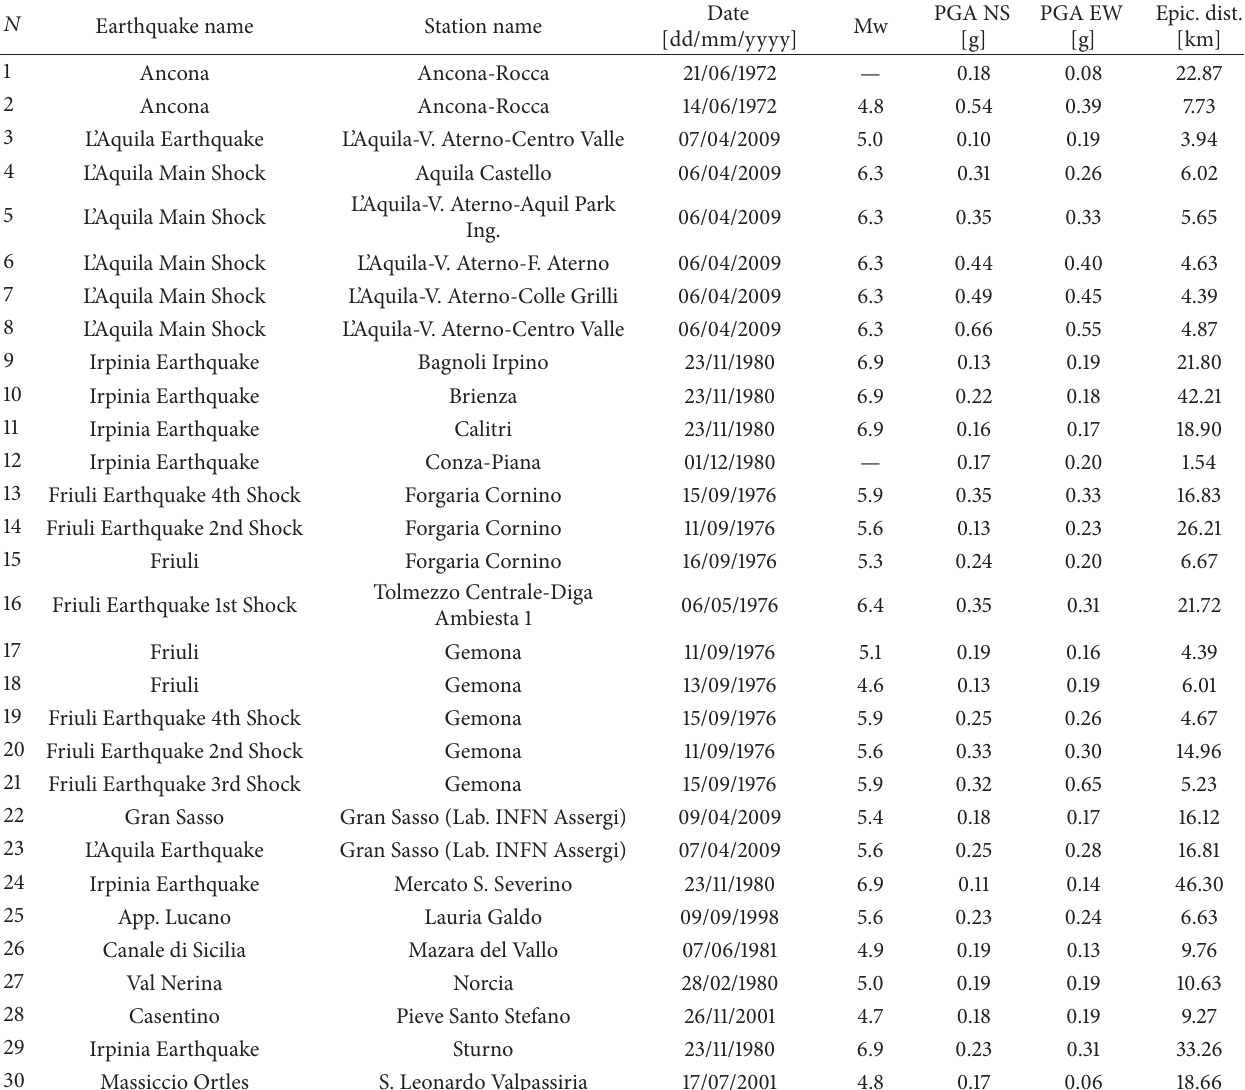
Table 2: The Italian ground motions selected for the analyses (ITACA database